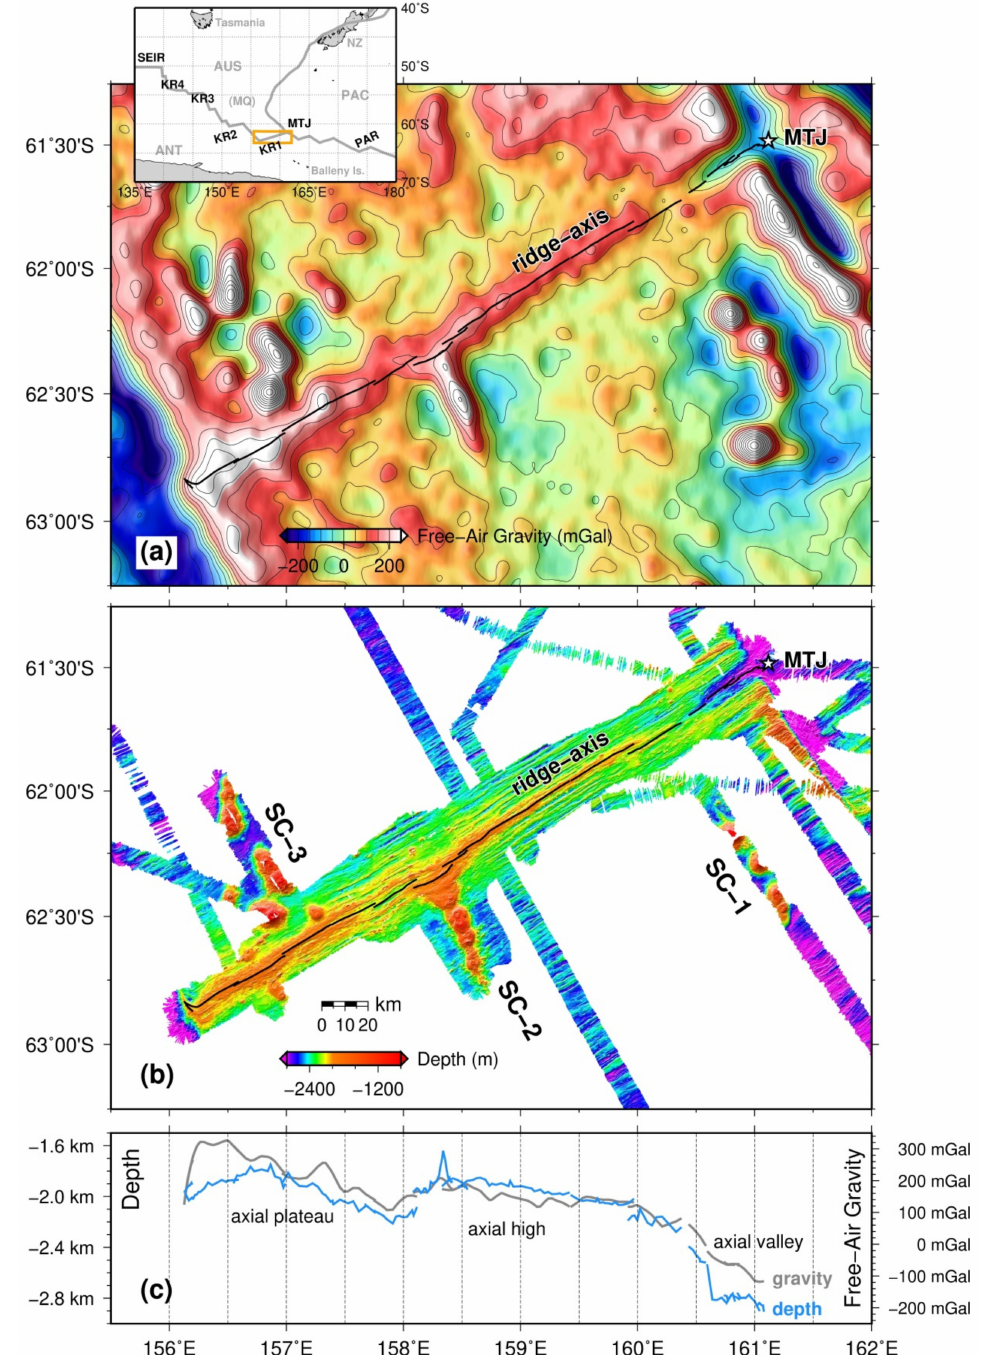
Figure 1. ( a ) Satellite-derived free-air gravity map of KR1, with a contour interval of 50 mGal (version 23.1) [19]. The spreading axis of KR1, the easternmost segment of the Australian-Antarctic Ridge (AAR), is illustrated by black solid lines. Major tectonic structures near KR1 are shown in the inset map: AUS = Australian Plate; ANT = Antarctic Plate; PAC = Pacific Plate; MQ = Macquarie Plate; SEIR = Southeast Indian Ridge; PAR = Pacific-Antarctic Ridge; MTJ = Macquarie Triple Junction; NZ = New Zealand; ( b ) high-resolution bathymetric map of the study area; ( c ) variations in depth and gravity along the ridge-axis of KR1. Blue lines show the seafloor depth from the observed multi-beam data, whereas gray lines show the free-air gravity anomalies derived from the satellite altimetry data (version 23.1)